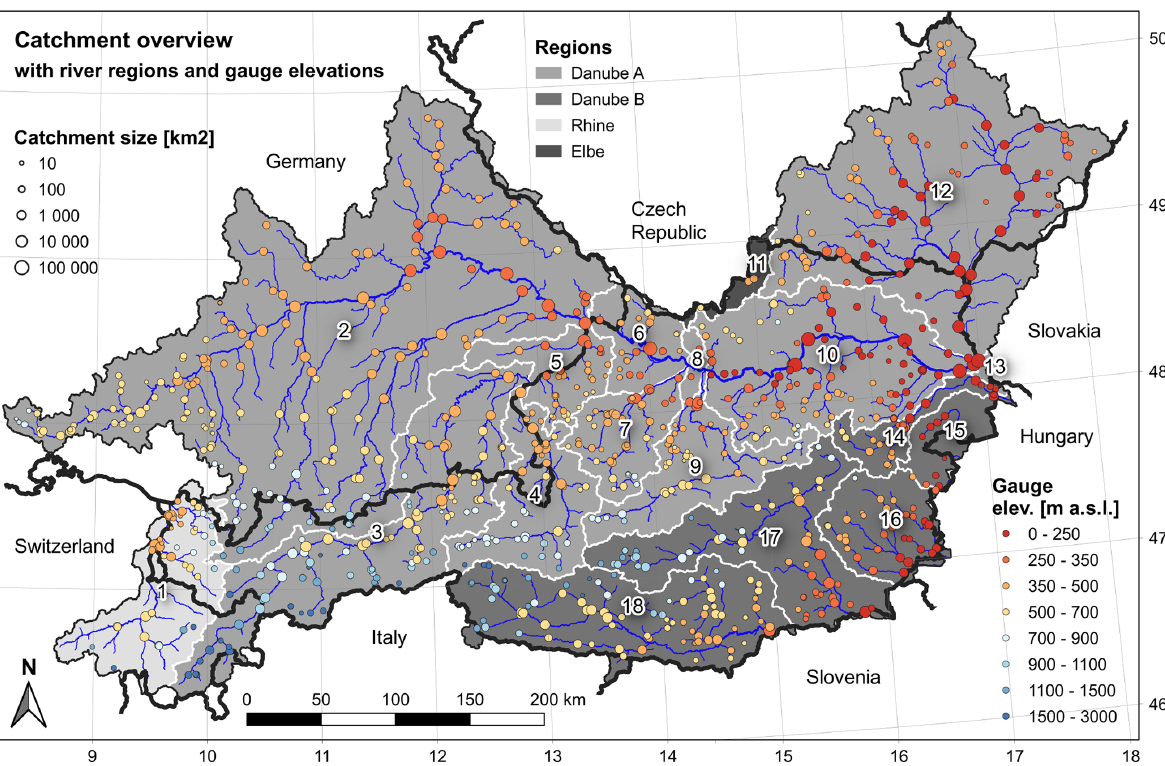
Figure 1. Overview of the area covered in LamaH (grey tones), and the runoff gauges with gauge elevation (circle color) and catchment area (circle size). LamaH is divided into different river regions, which are bordered by the white lines. The black numbers are abbreviations of the individual regions, which are indicated in Table B1. The national borders are shown as thick black lines. Source of stream network: HydroATLAS (Linke et al., 2019). © EuroGeographics for the administrative